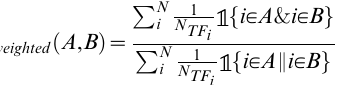
Figure S1 Method details. (A): The distance between TF binding sites from ENCODE and the nearest gene in RefGene are shown. (B): The distribution of genes putatively regulated by each of the transcription factors (TFs) on the basis of their proximity is shown. genes. (C): Enrichment between genes regulated by each TF